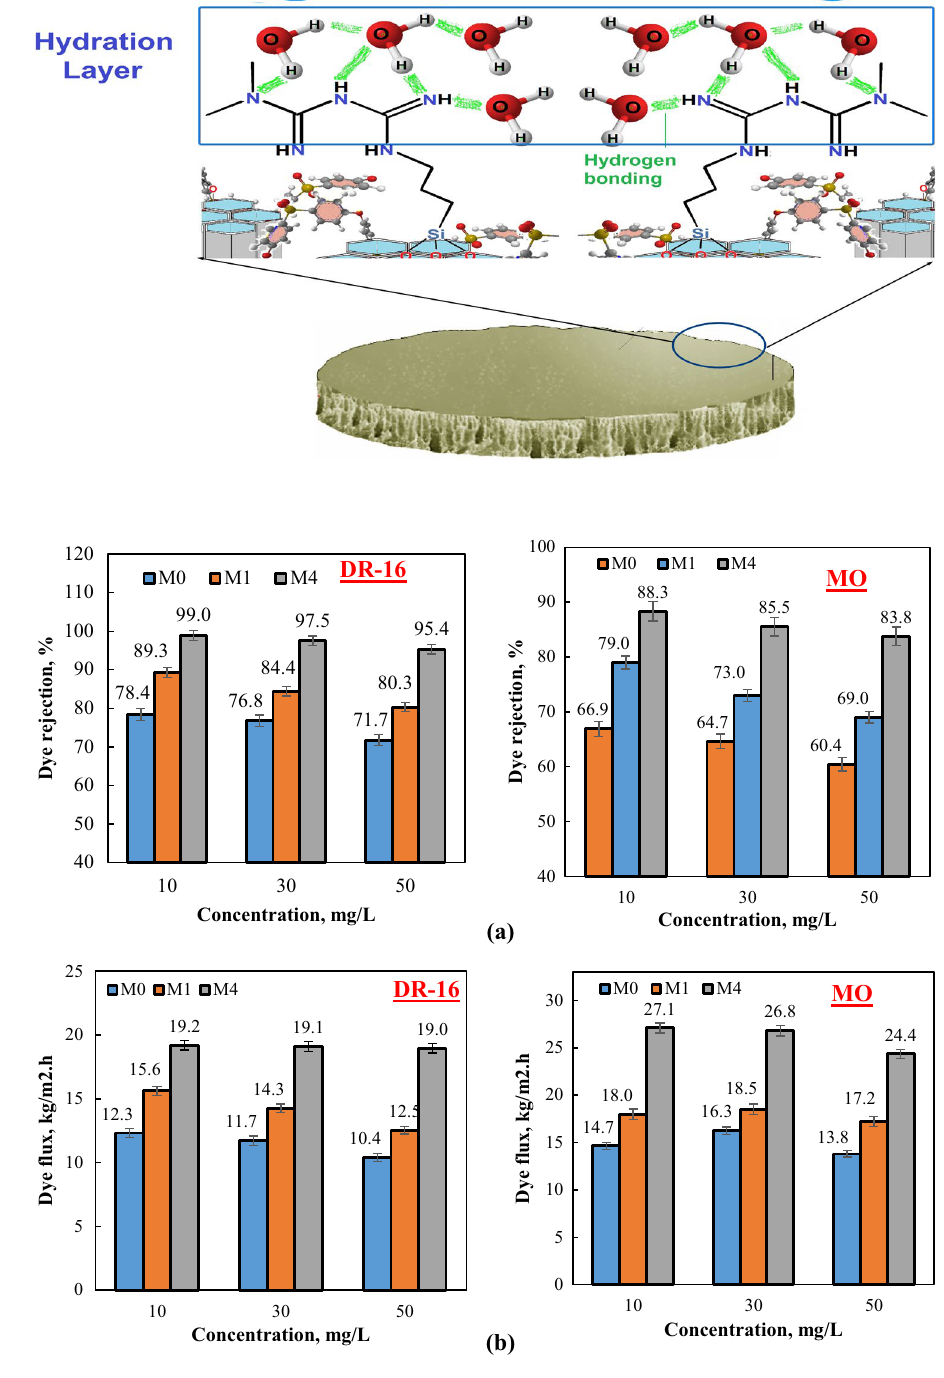
Fig. 9 Interaction between dye molecules and metformin groups on the membrane surface